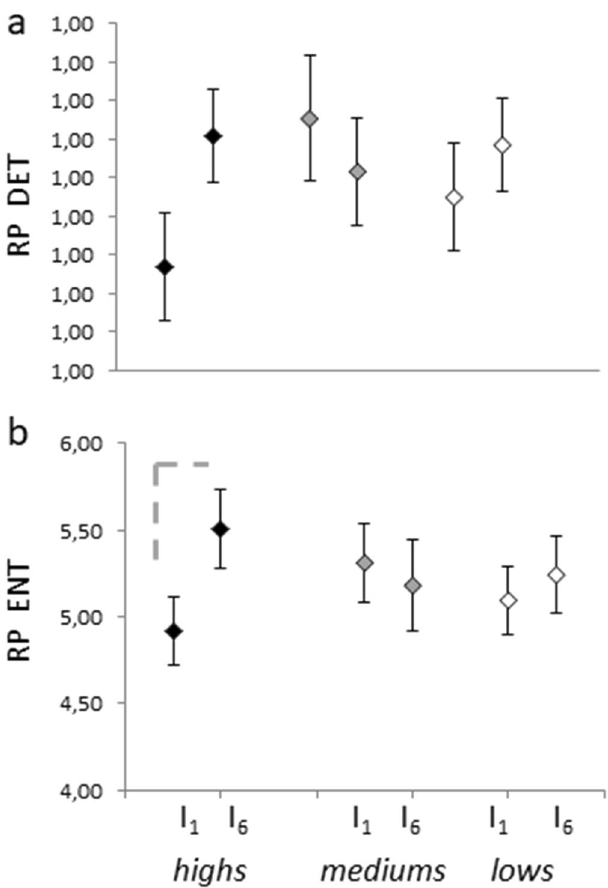
Figure 4. Determinism and Entropy of the pupil signal Recurrence Plot. ( a ) Determinism and ( b ), Entropy in I 1 and I 6 . The dotted line indicates differences approaching significance ( p = .029 with the level of significance set at p = 0.025 after Bonferroni